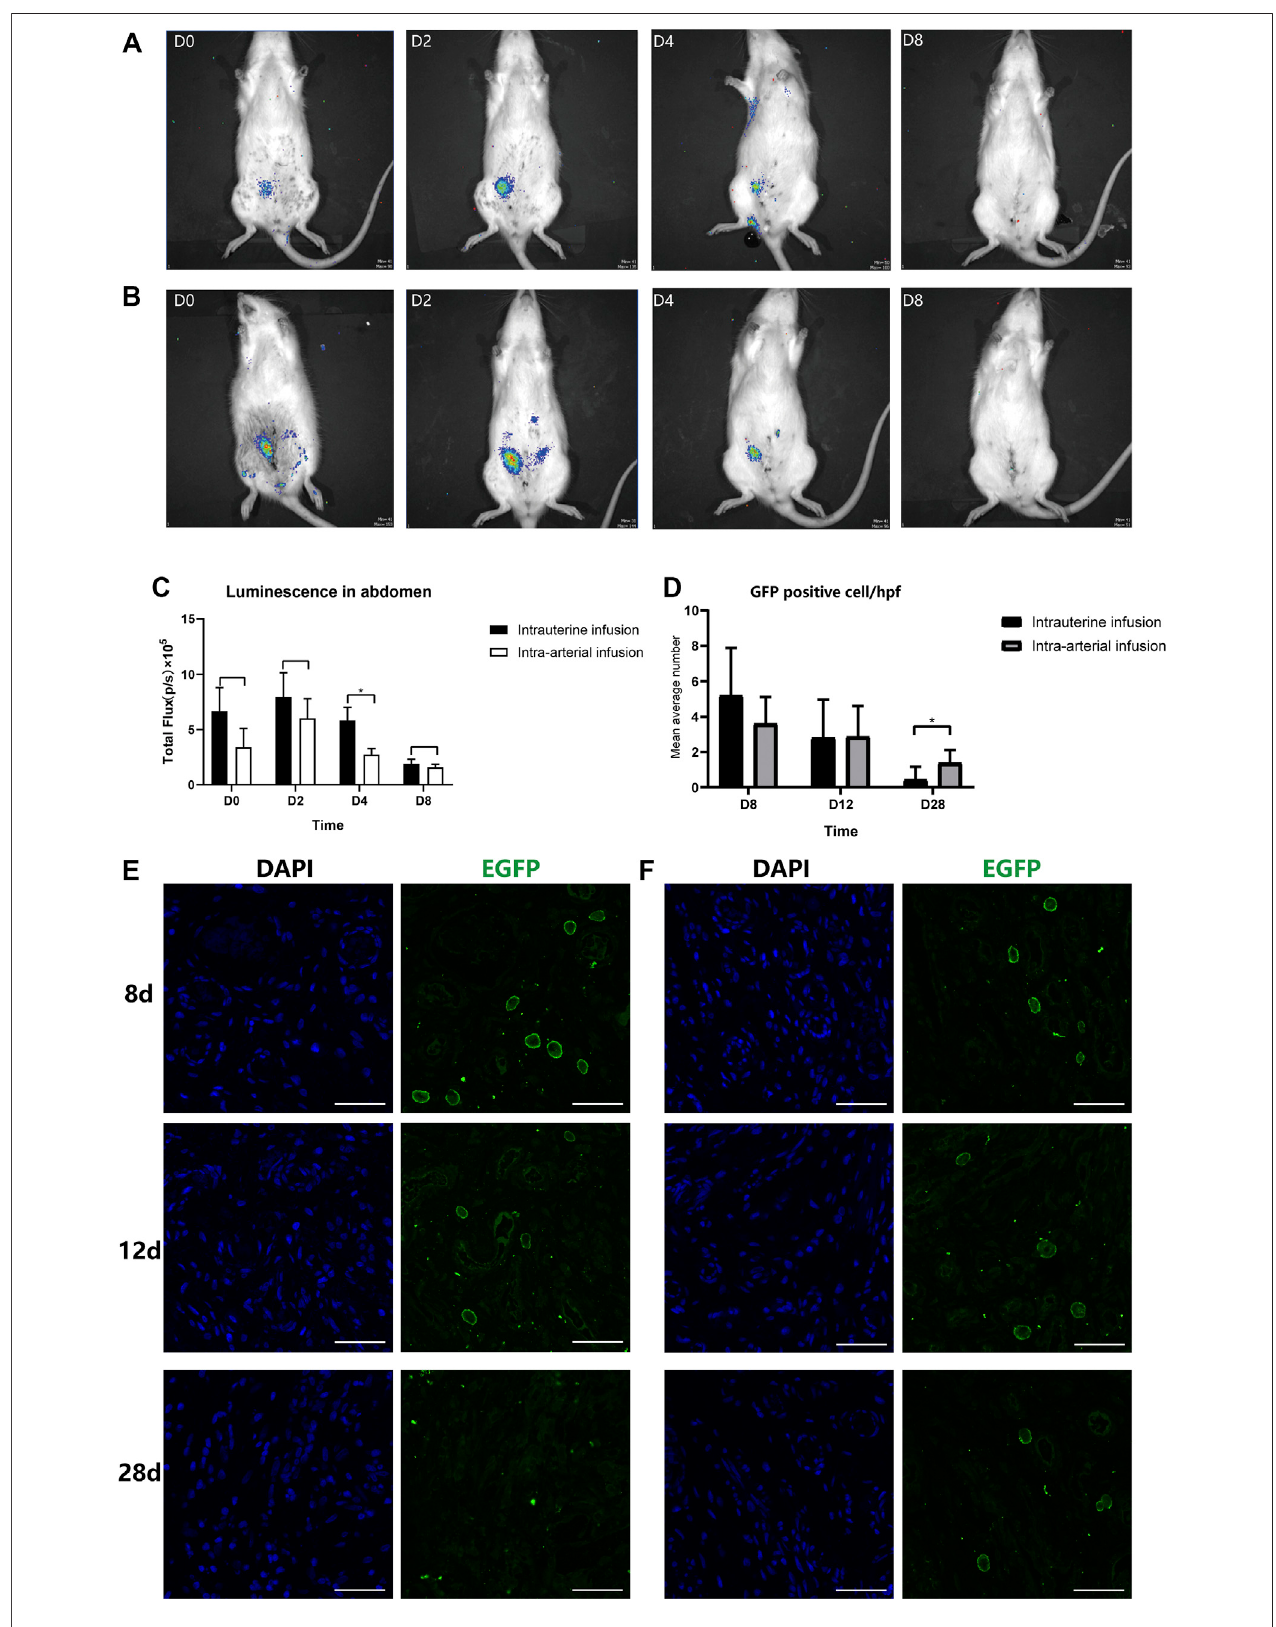
FIGURE 3| In vivo and in vitro tracking of transplanted BMSCs. The recruitmentand retention ofBMSCsat the injured horn in two groups ( (A) : intra-artery, IA; (B) : Frontiers in Bioengineering and Biotechnology |